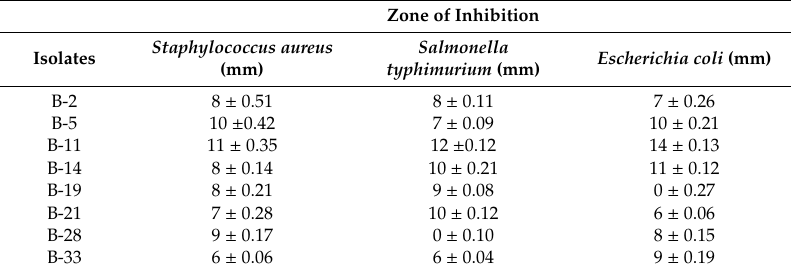
Table 3. Antibacterial activity of isolates (means ± SD).